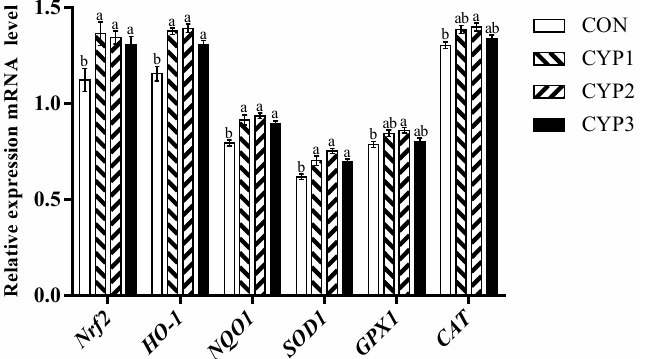
Figure 1. The Nrf2 , HO-1 , NQO1 , SOD1 , GPX1 , and CAT mRNA expressions of liver in broilers. Different lowercase superscripts indicate significant differences ( p < 0.05). CON = control diet; CYP 1 = control diet adds 250 mg CYP per kilogram; CYP 2 = control diet adds 500 mg CYP per kilogram; CYP 3 = control diet adds 1000 mg CYP per kilogram. Nrf2 , nuclear factor-erythroid 2-related factor 2; HO-1 , heme oxygenase 1; NQO1 , quinone oxidoreductase; SOD1 , superoxide dismutase 1; GPX1 , glutathione peroxidase 1; CAT , catalase.